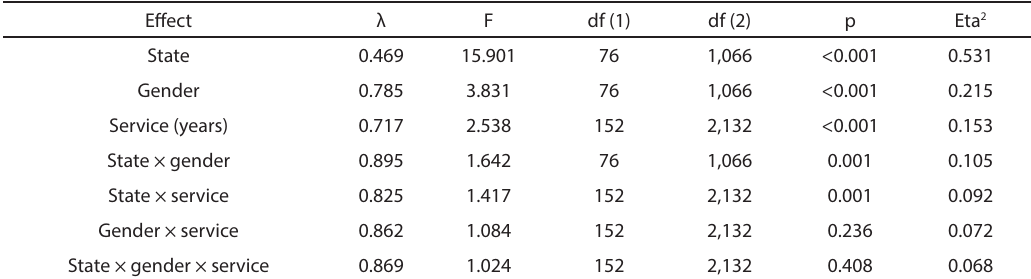
Table 2. MANOVA table for the multivariate differences in professional competences between states controlled for gender and years of